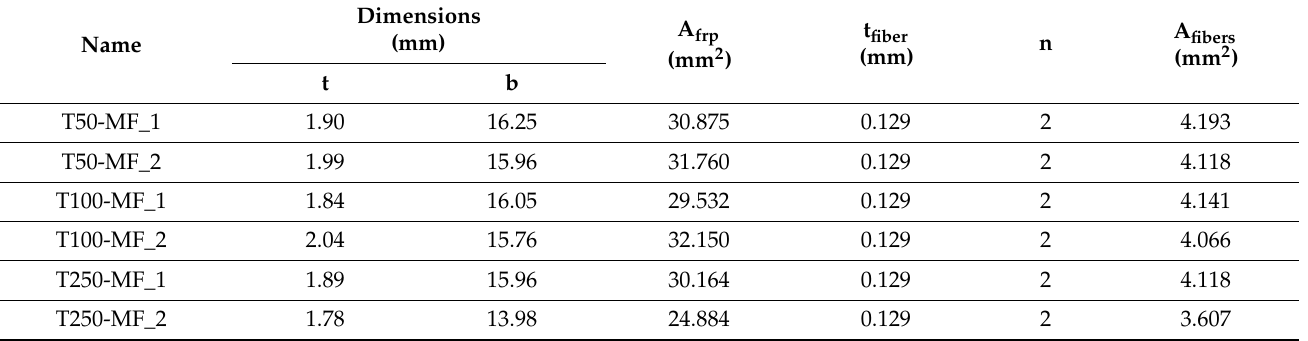
Table 4. Characteristics of specimens of experiments under elevated